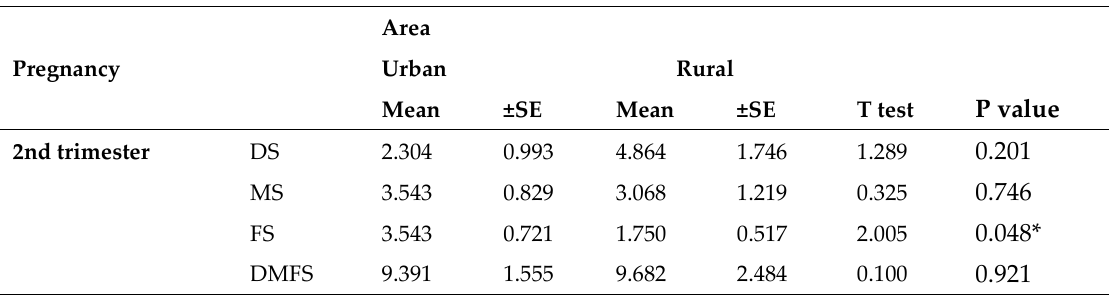
Table 5: Descriptive and statistical tests of dental caries experience (DMFS) among pregnant women by area.